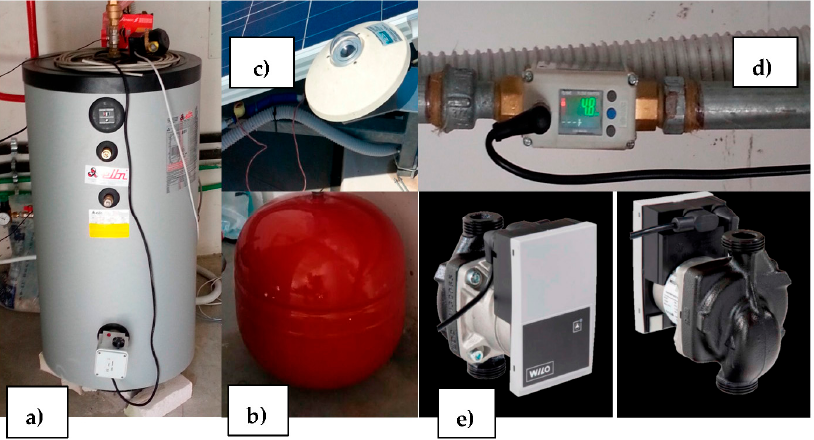
Figure 2. ( a ) BSV-200 Elbi storage tank; ( b ) expansion vessel; ( c ) LP PYRA 02 AC pyranometer; ( d ) SMC LFE 1D4F1 flowmeter; ( e ) WILO Yonos PARA ST 7.0 PWM2 flow rate pump.